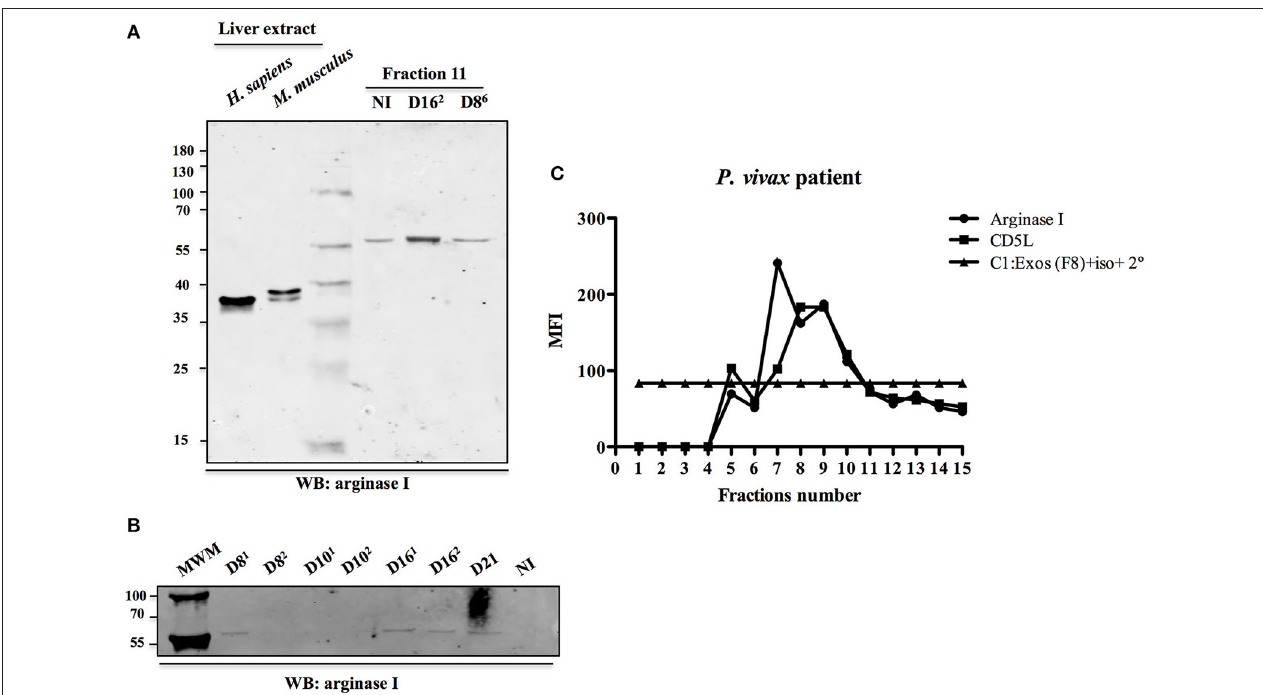
FIGURE 5 | Validation of arginase I as an exosomal-associated protein. (A) Commercial anti-arginase I antibodies were used to analyze the presence of arginase I in SEC fraction 11 from P. vivax infected at 8 and 16 dpi (EI1: D8 6 and EI2: D16 2 ) and uninfected (NI) FRG huHep mice. These samples correspond to mice where arginase I was identified by LC-MS/MS. An equal volume of each fraction was loaded on the gel. Ten micro grams of liver extract from mouse and human were used as positive controls. (B) Western blot analysis of ExEFs purified from P. vivax infected FRG huHep mice from EI2 on days 8, 10, 16, and 21 post-infection. An equal volume of CD5L-highest fraction was loaded on the gel. (C) Flow cytometry bead-based assay showing arginase I detection in exosomal fractions isolated from plasma of a P. vivax patient. This sample correspond to an unidentified stored plasma of the biobank from the FMT-HVD. Mean fluorescence intensity (MFI) of anti-arginase and control antibodies (rabbit-isotype) was assayed for each fraction. CD5L was used as plasma exosomal